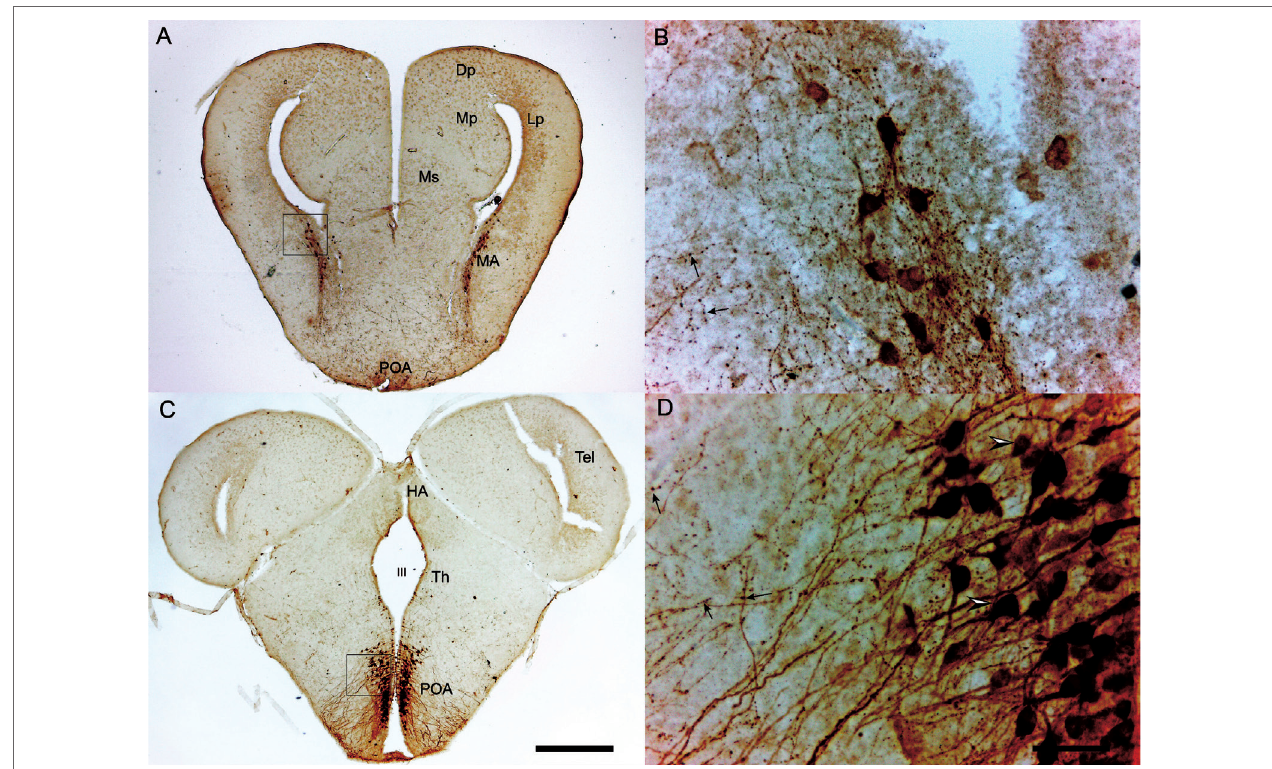
FiGURe 2 | Transverse sections through the brain of a Pleurodema thaul male showing arginine vasotocin (AVT)-immunoreactive cells at the level of amygdala (A,B) and preoptic area (POA) (C,D) . (A) AVT cells in the medial amygdala (MA). AVT cells in the inset are magnified in (B) ; arrows indicate axonal varicosities characteristic of AVT neurons in many vertebrates. (C) AVT cells in the caudal POA. AVT cells in the inset are magnified in (D) ; arrowheads show parvo- (upper) and magnocellular (lower) neurons, which are interspersed in this magnocellular region of the POA. Scale bars on panel (C) (0.5 mm) and (D) (50 µm) also apply to (A,B) respectively. See abbreviation section for abbreviations